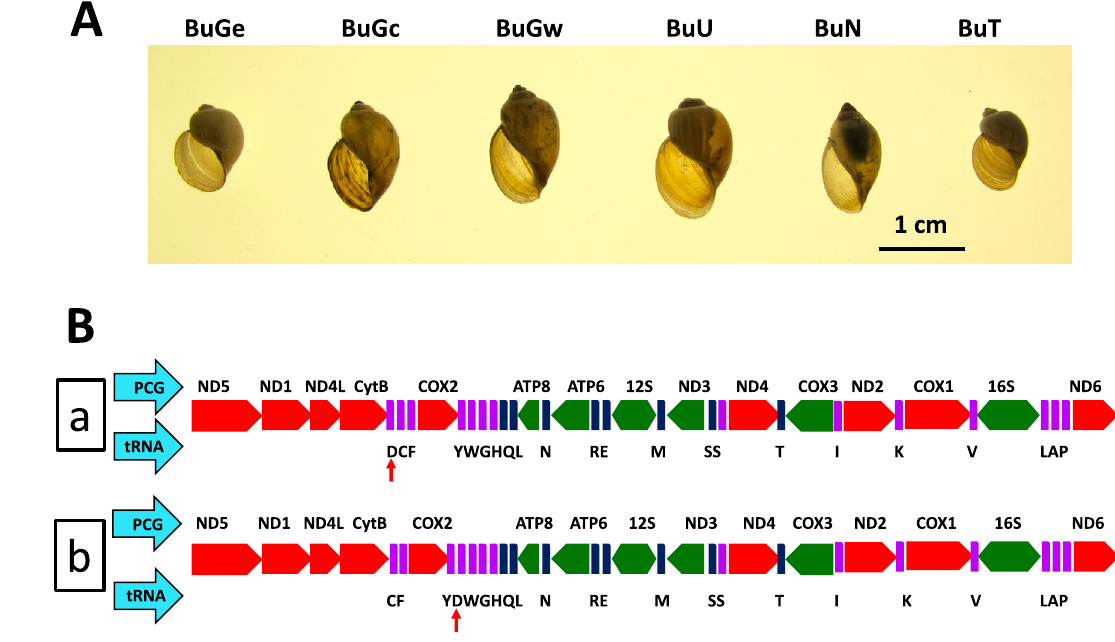
Figure 1. Shell morphology of six snail specimens ( A ) and arrangement of protein-coding genes (PCG) and tRNAs of six mitogenomes ( B ). In part B , diagram a shows the gene arrangements of the mitogenome of B. globosus , B. nasutus and B, ugandae whereas b shows the mitogenome of B. truncatus . Note the different position of tRNA-Asp (red arrow). The abbreviations of BuGe, BuGc and BuGw are three specimens of B. globosus that were collected from eastern, central, and western Kenya, respectively. BuT, BuN, and BuU represent B. truncatus, B . nasutus , and B. ugandae, respectively. The same abbreviations are applied to all figures below and supplementary Table